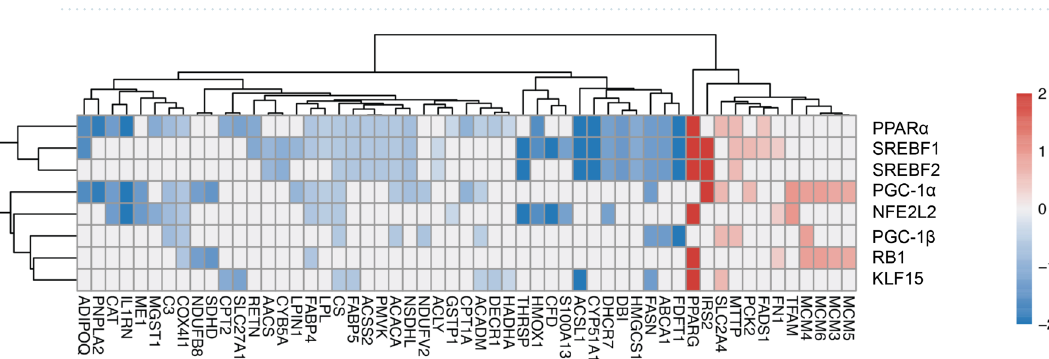
Figure 5. Identification of significantly-affected transcription factors and target mapping in SIRT1-depleted adipocytes. Heatmap clustering of the most significantly-affected molecules mapped to their upstream regulators in SIRT1-depleted adipocytes. Red and blue indicate up- and down-regulated molecules, respectively. Shown are upstream regulators with a downstream target overlap of P < 10 –5 and an IPA activation z score > 2.7 or < − 2.7. The activation z score was calculated by IPA and it predicted if a pathway was activated or inhibited based on the directional change in proteins included in the quantified